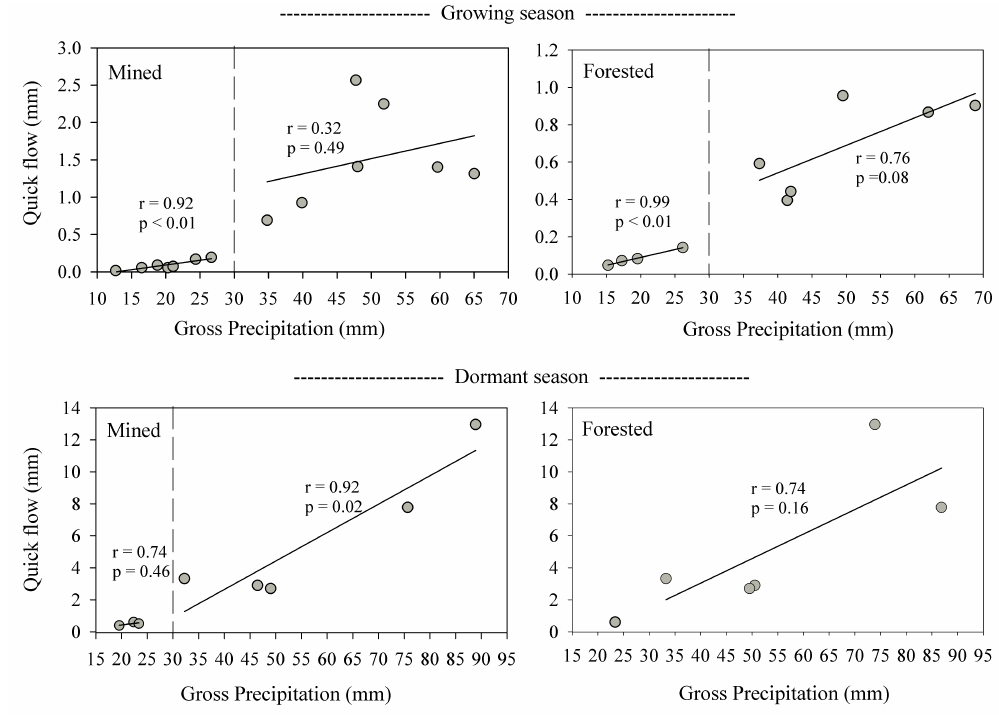
Figure 7. Gross precipitation and quickflow for all events based on the growing season and the dormant season for the mined and forested catchment. The threshold value is ∼ 30 mm. Quickflow response is non-linear and generally more variable above threshold values. r 2 is the coefficient of determination based on regression